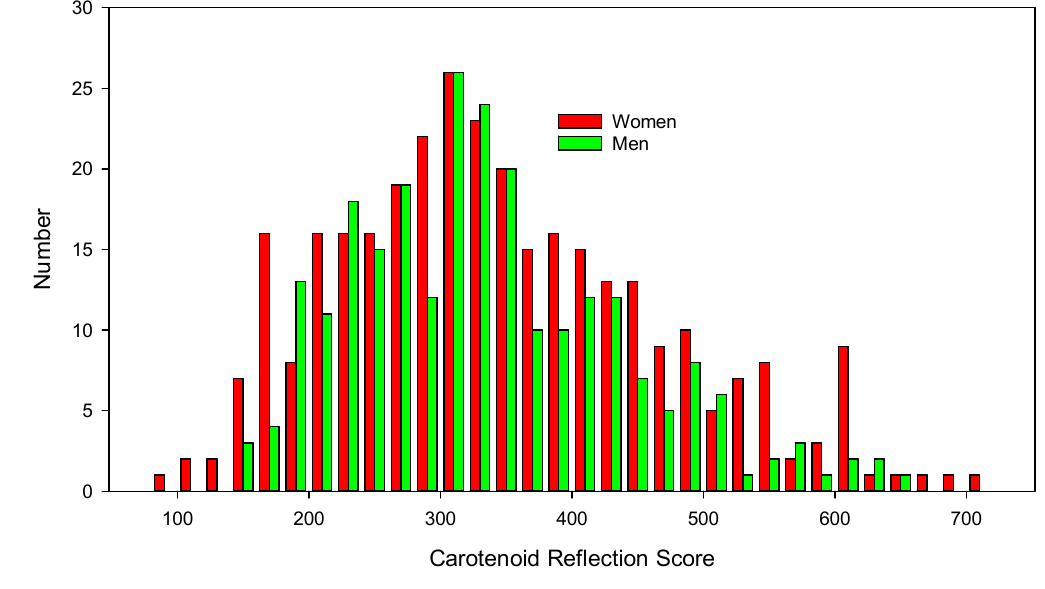
Figure 1. Histogram of carotenoid reflection scores in the study population. Table 1. Carotenoid reflectance scores of participants by age, ethnicity and gender. Carotenoid Reflection